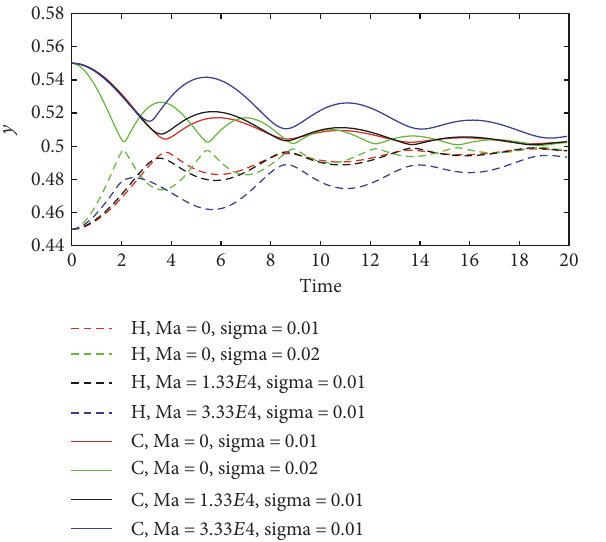
Figure 4: Curve of the position of wave crest and trough with time. H is the trough, C is the crest, Re =12.5. Figure 5: Temperature changes of